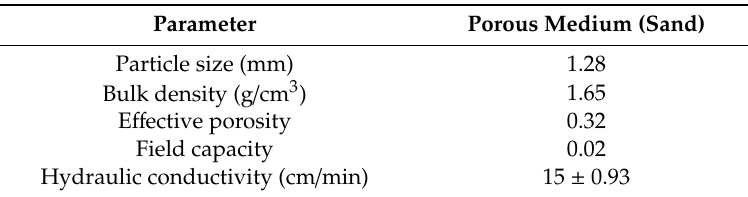
Table 1. Measured hydraulic properties of Table 1 . Measured hydraulic properties of sand.